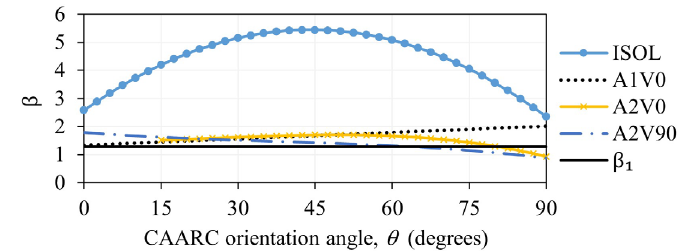
Figure 7. Reliability index β for acceleration, x-direction – limit criterion of 8.4 cm/s 2 .